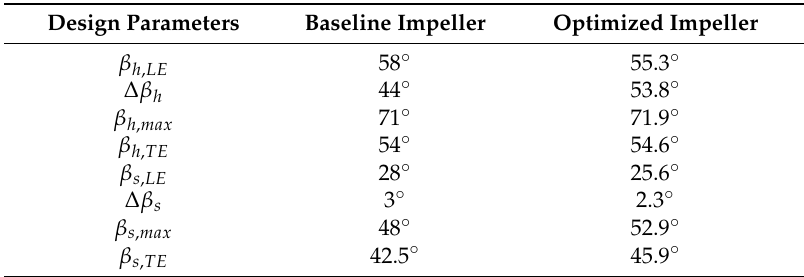
Table 5. Value of Beta distribution parameters of reference and optimized impellers.